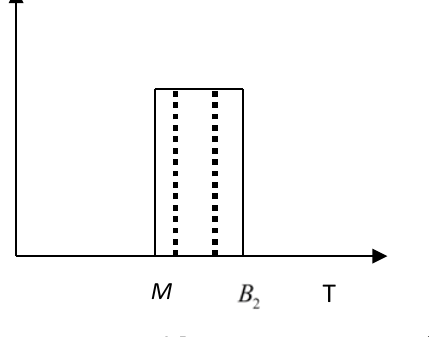
Fig. 5. Interest earned in scenario 1.1.1.1. (b) Fig. 6. Interest payable in scenario 1.1.1.1.